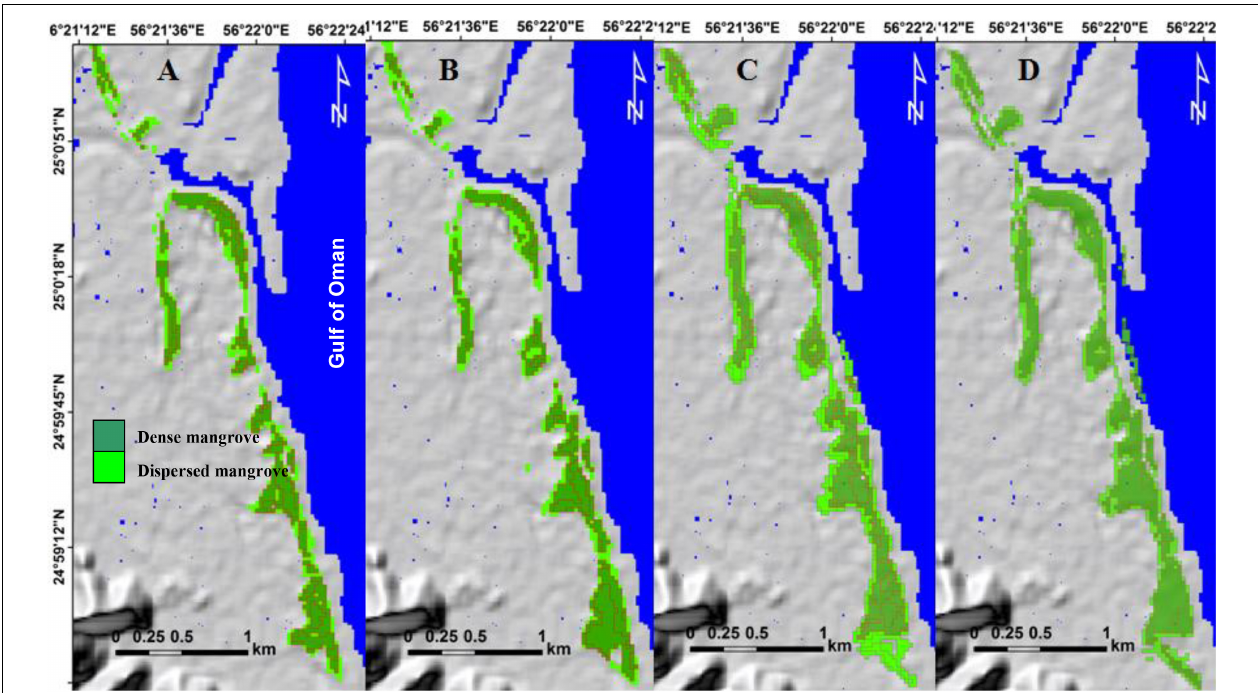
FIGURE 7 | Spatiotemporal variation of mangrove forests in Khor Kalba of the Emirate of Sharjah for the years 1990 (A) , 2000 (B) , 2010 (C) , and 2019 (D) .